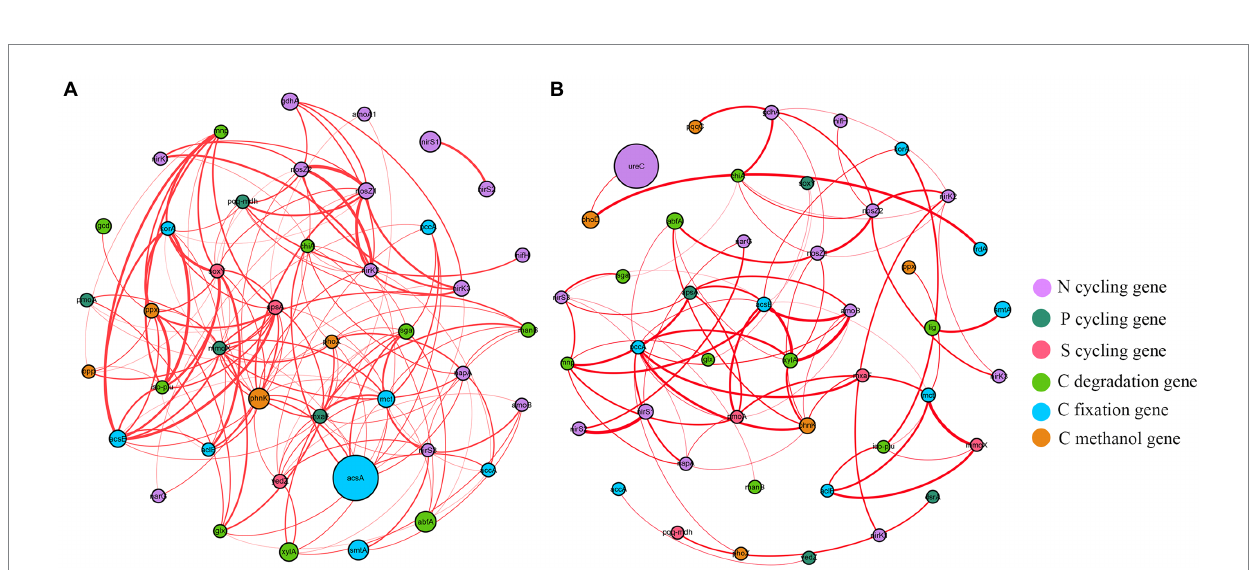
FIGURE 4 The co-occurrence network visualization of functional genes (R > 0.8 and p < 0.05) in A . palmeri (A) and native (B) rhizosphere soils. Nodes indicate functional genes. The size of each node is proportional to the relative abundance of each gene. And the thickness of each connection between two nodes (that is, edge) is proportional to the value of Spearman’s correlation coefficients. Edge color represents positive (red)